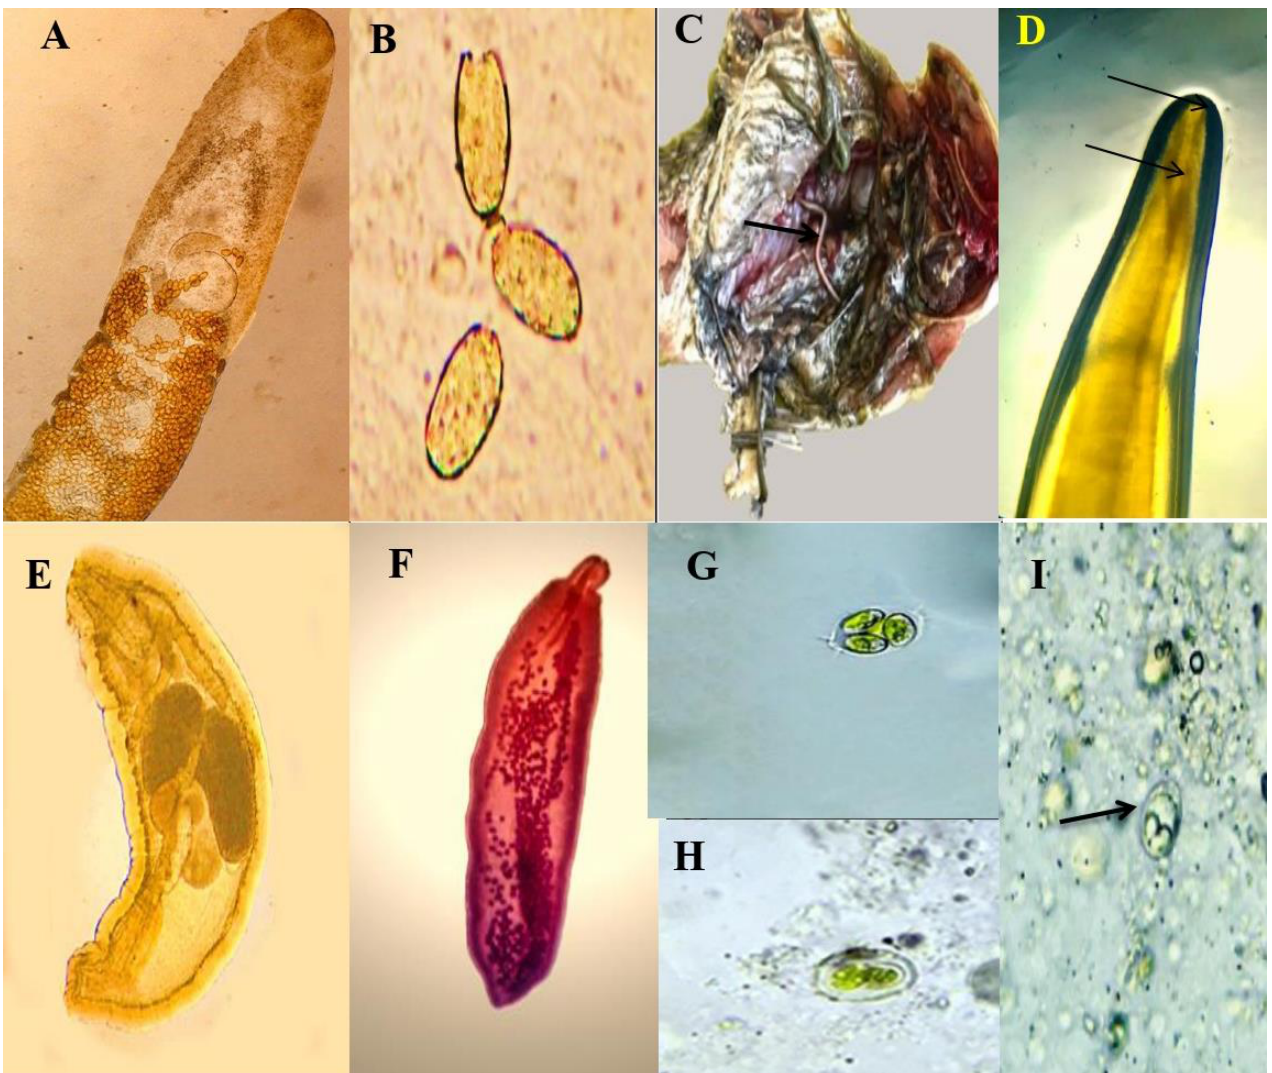
Figure 2. Endoparasites of Nile tilapia. ( A ) Orientocreadium batrochoides recovered from intestine × 100; ( B ) egg of Orientocreadium batrochoides × 400, small sized egg, yellowish in color and operculated; ( C ) larva of Contraecum in the body cavity of Nile tilapia; ( D ) anterior region of Contracecum × 100 (ar- rows show (1) boring tooth and (2) esophagus); ( E ) wet mount of Acanthosentis tilapiae . Male recovered from intestine of Nile tilapia × 100; ( F ) female A. tilapiae stained with alum carmin; ( G ) sporulated oocyst of Eimeria spp. × 1000; ( H ) sporulated oocyst of Isospora spp. × 1000; (I) Myxobolus spp. × 1000 (arrow shows polar cap- sule).